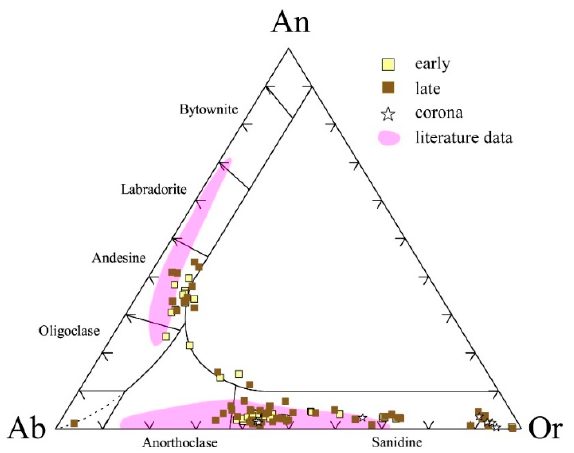
Figure 3. Ternary classification diagram Ab-An-Or for feldspars [49] showing all plagioclase and alkali-feldspar crystals analysed in the selected MEGT volcanic rocks. Ab = albite molar %, including Sr-feldspar; An = anorthite molar %; Or = orthoclase molar %, including celsian. Early = phenocryst core; late = phenocryst rim, microphenocrysts and groundmass microlites; overgrowth on phenocryst. The pink fields are drawn using mineral chemistry data on Ischia trachytes and phonolites from the literature [14,19,41,43].